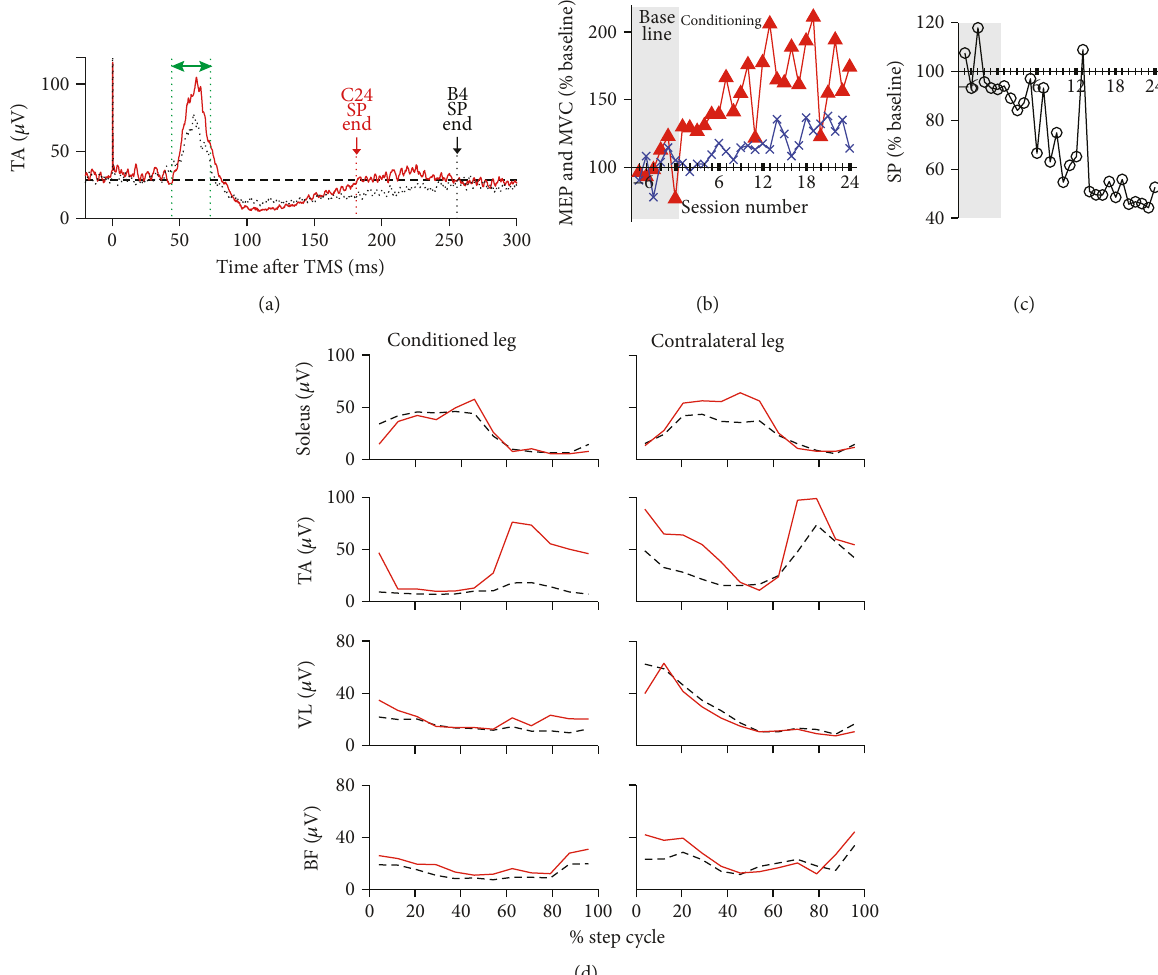
Figure 2: Changes in tibialis anterior (TA) motor-evoked potential (MEP), maximum voluntary contraction (MVC), and silent period (SP) over the course of study, and bilateral locomotor EMG activity in subject A. (a) Recti fi ed EMG signals from the fourth baseline session (dashed black) and the last (i.e., 24th) conditioning session (solid red). Two hundred twenty- fi ve responses were averaged together for each sweep. A pair of dashed vertical lines (green) indicates the time window for this subject ’ s MEP size calculation. The horizontal line at 30 μ V indicates the background EMG level. (b) Mean MEP size (i.e., the mean of 225 control (in baseline sessions) or 225 conditioned